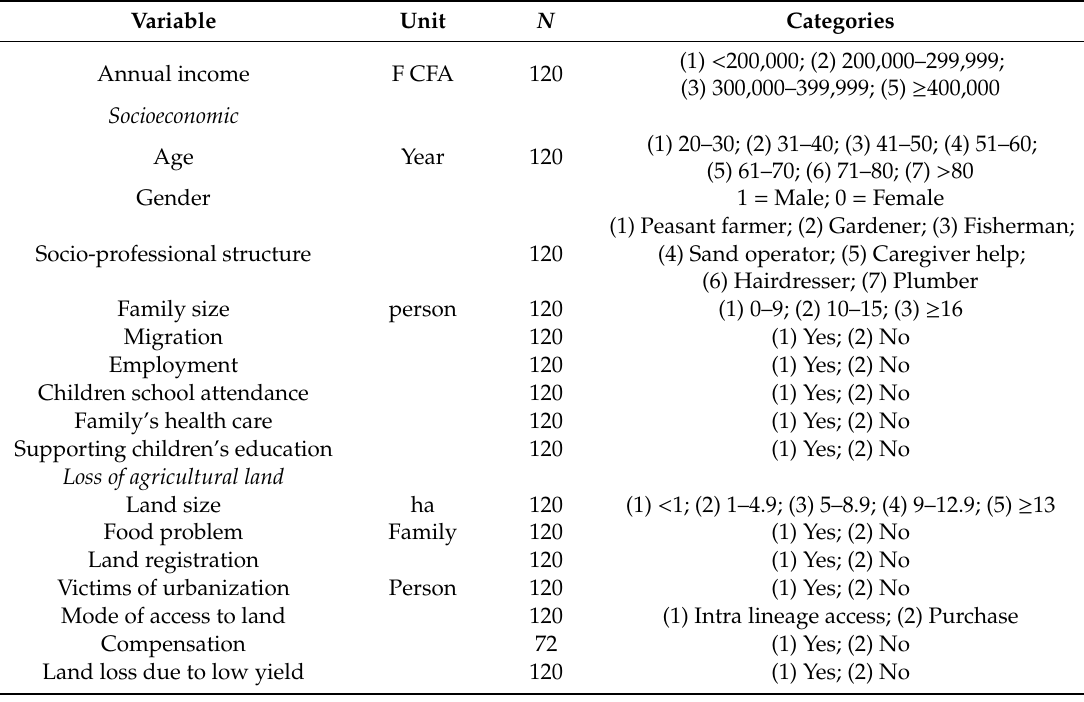
Table 1. Definitions of the